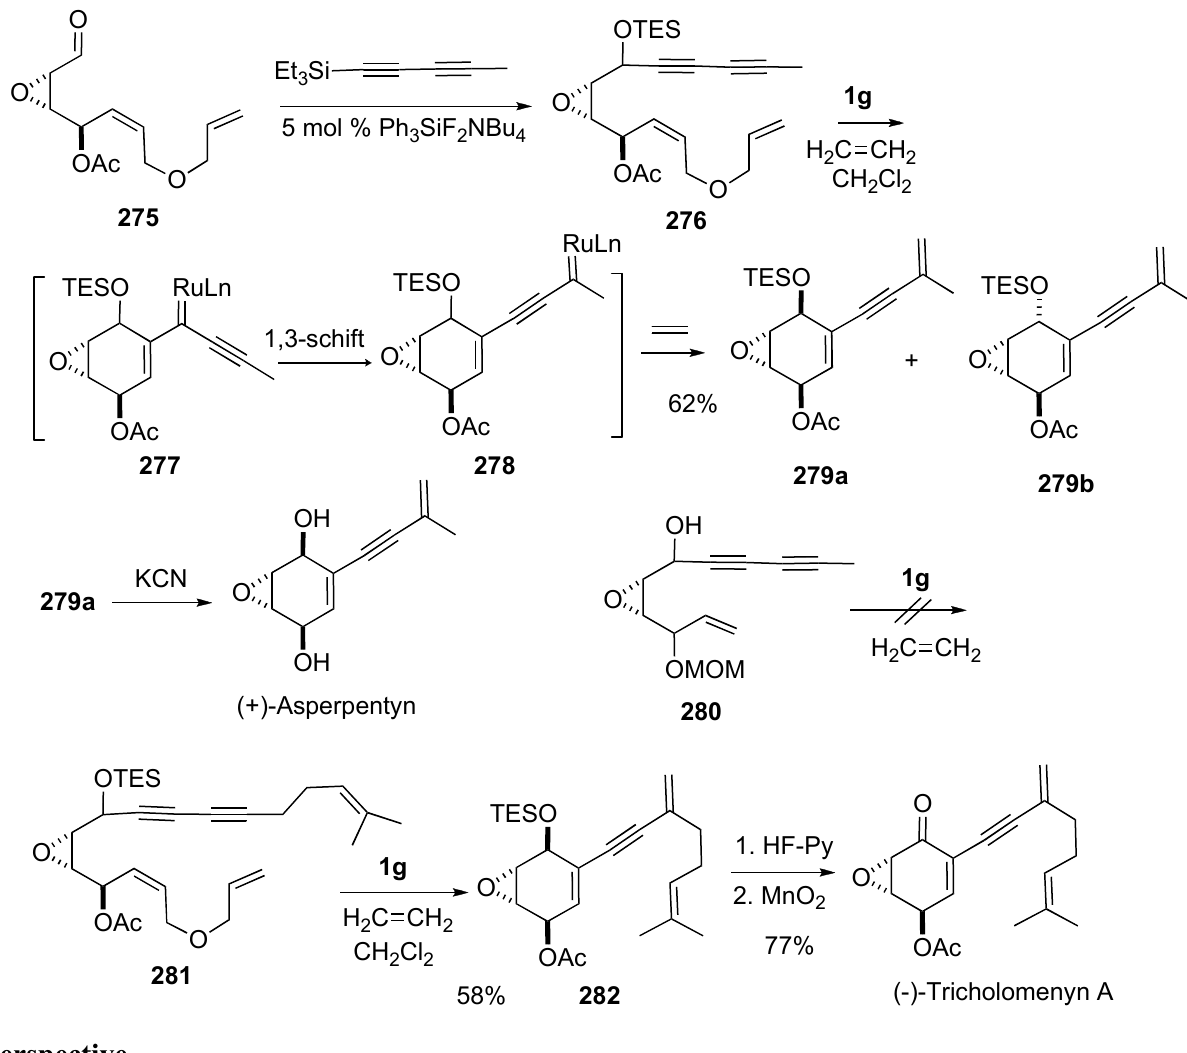
Scheme 74. Synthesis of (+)-asperpentyn and (+)-tricholomenyn A using tandem enyne